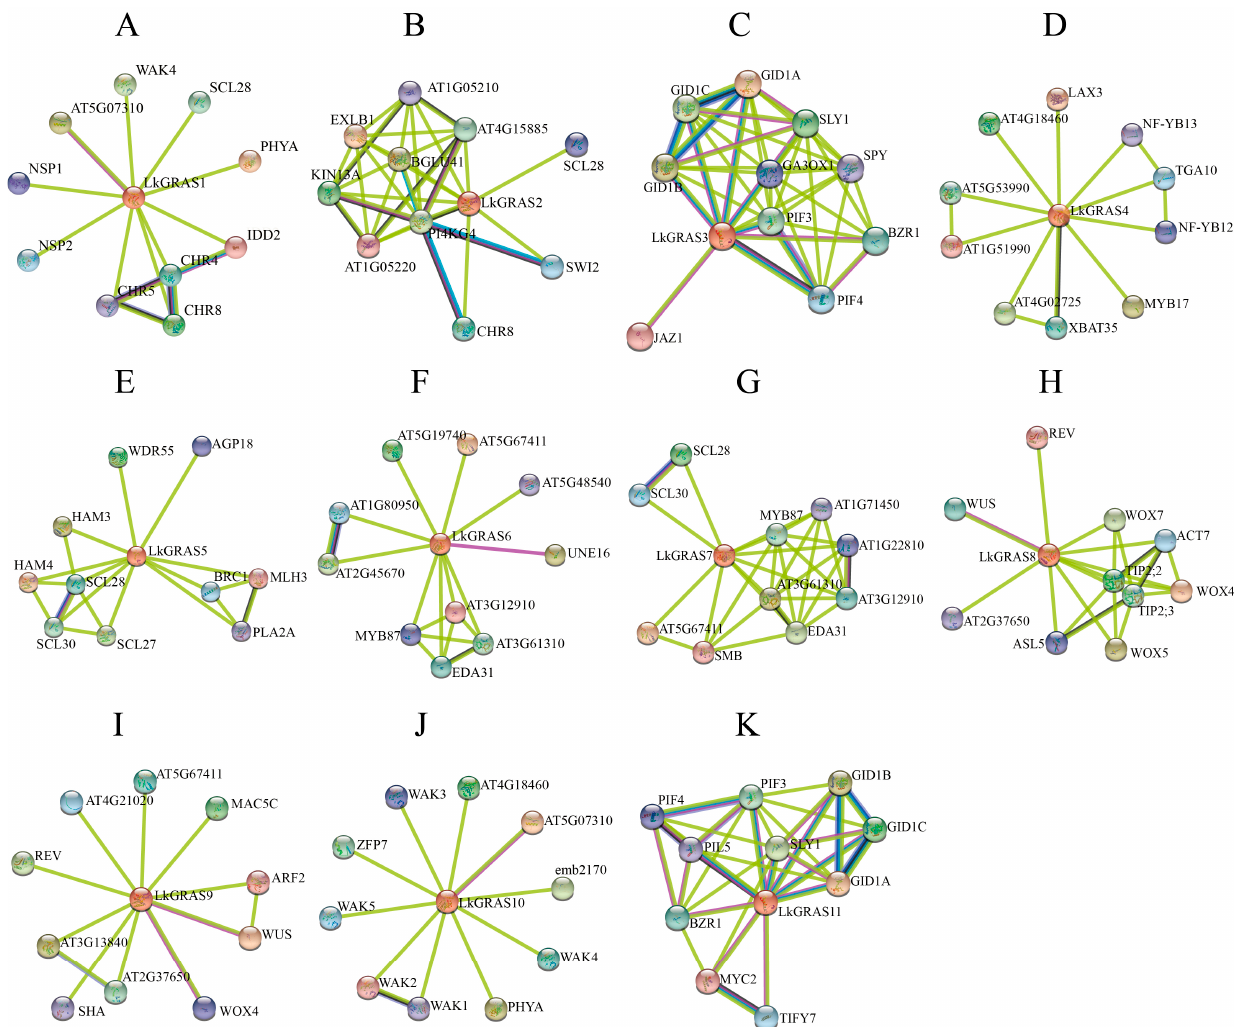
Figure 8. The predicted protein interaction network of LkGRAS proteins. ( A – K ) The potential protein interaction networks of each protein were predicted by the STRING database. Different colored lines represent different evidence of an